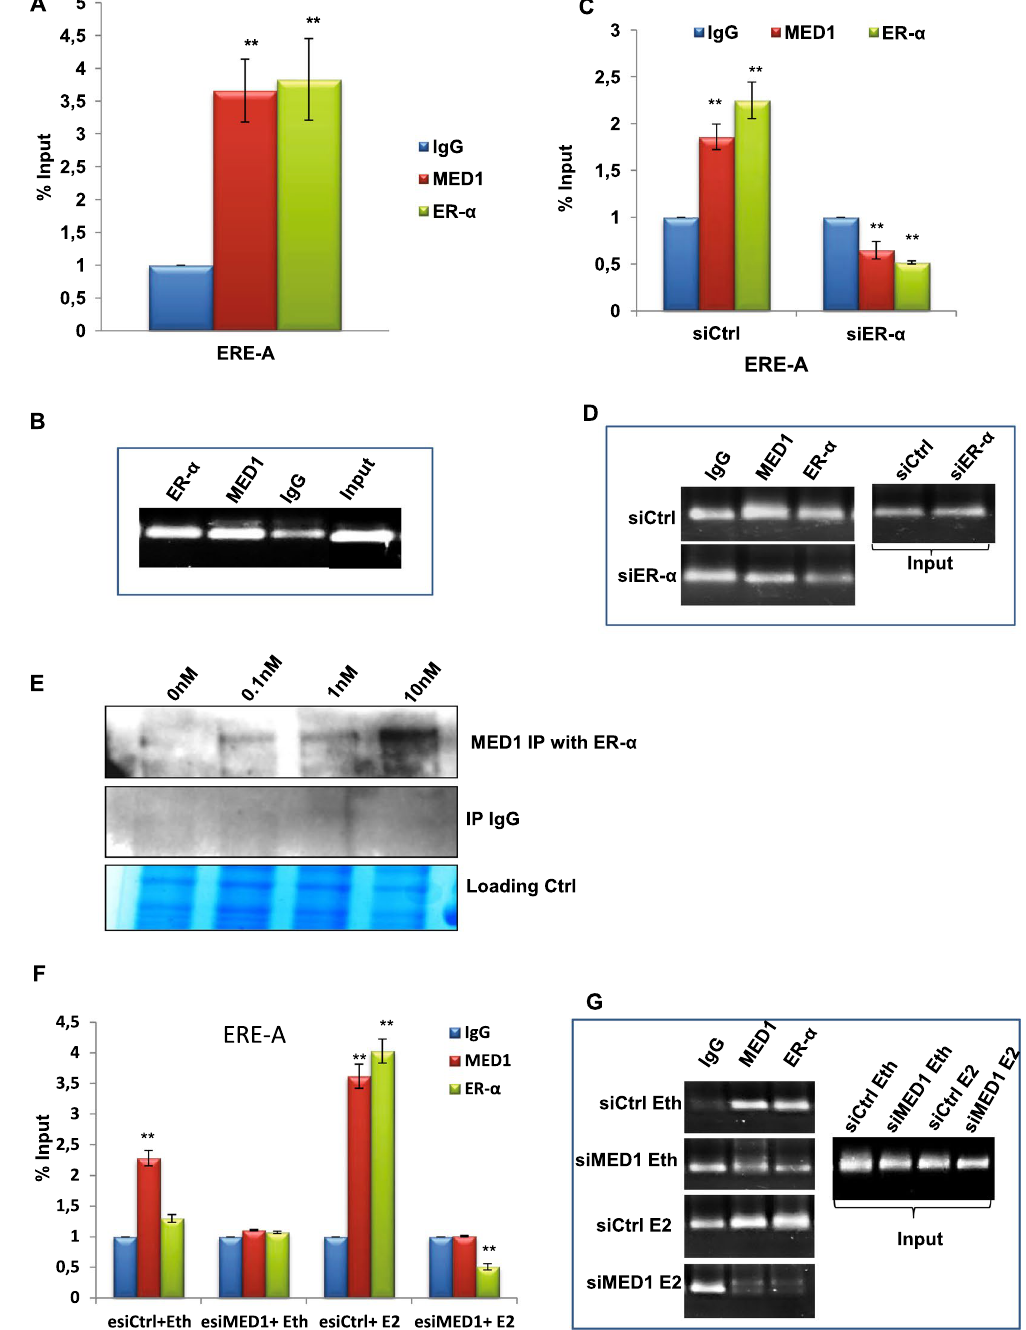
Figure 5. Recruitment of MED1/ER- α on the miR-191/425 promoter ERE. ( A , B ) qPCR ( A ) or semi- quantitaive ( B ) data of CHIP assay showing % input of bound chromatin on ERE-A element using antibody specific to MED1/ER- α . ( C , D ) qPCR ( C ) or semi-quantitative ( D ) data of CHIP assay shows recruitment of both ER- α and MED1 on ERE-A in response to ER- α inhibition using specific siRNA. ( E ) Estrogen dependent MED1 and ER- α interaction in MCF7 cells. MCF7 cells were starved for estrogen for 3-4 days followed by estrogen treatment (0–10 nM) for 45 min. The cells were lysed and probed for the interaction of ER- α and MED1 using co-immunoprecipitation assay. ER- α antibody was used for pull down and western blotting was done with MED1 specific antibody. ( F , G ) CHIP assay was performed using ER- α or MED1 antibodies in response to 10 − 8 M estrogen (E2) or ethanol (Eth) treatment for 2 hrs with/without inhibition of MED1. qPCR ( F ) or semi-quantitative ( G ) data shows PCR based quantification of bound chromatin (% input) on ERE-A (element present upstream of miR-191/425 cluster) in MCF7 cells. ( ** P < 0.05). Error bars denote +